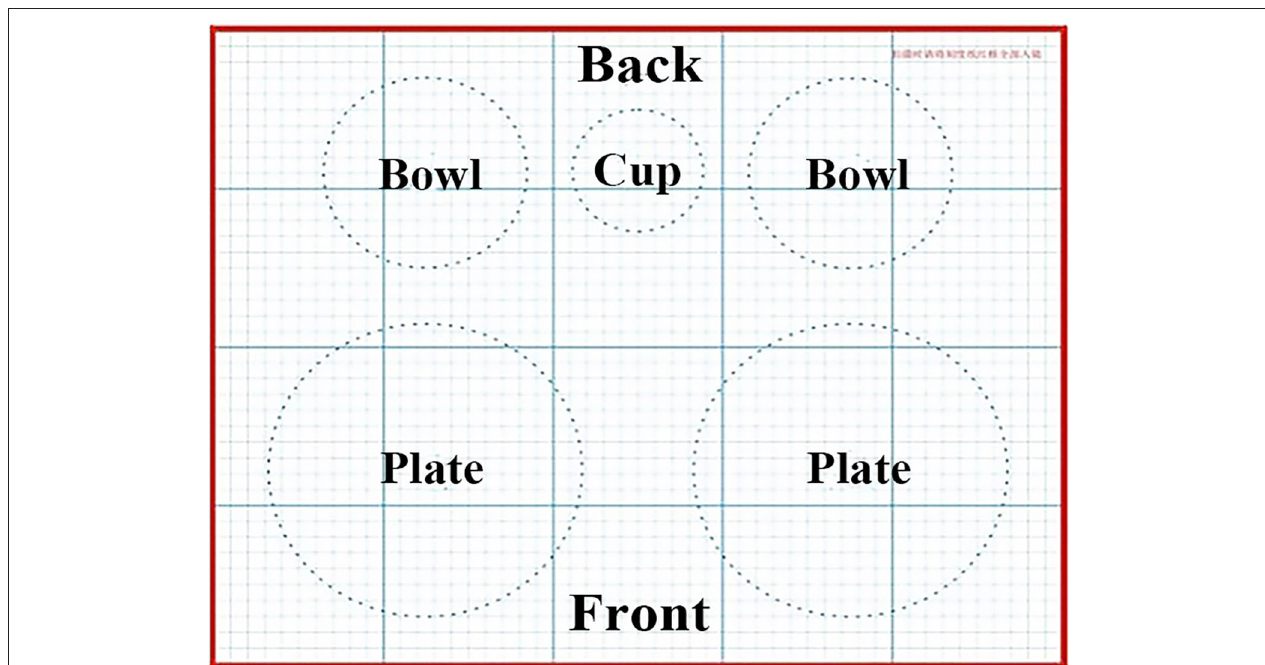
FIGURE 1 | The grid background paper necessary for the diet photography record (DP). The upper smaller circles were the position of two bowls and a cup, and the lower were the position of two